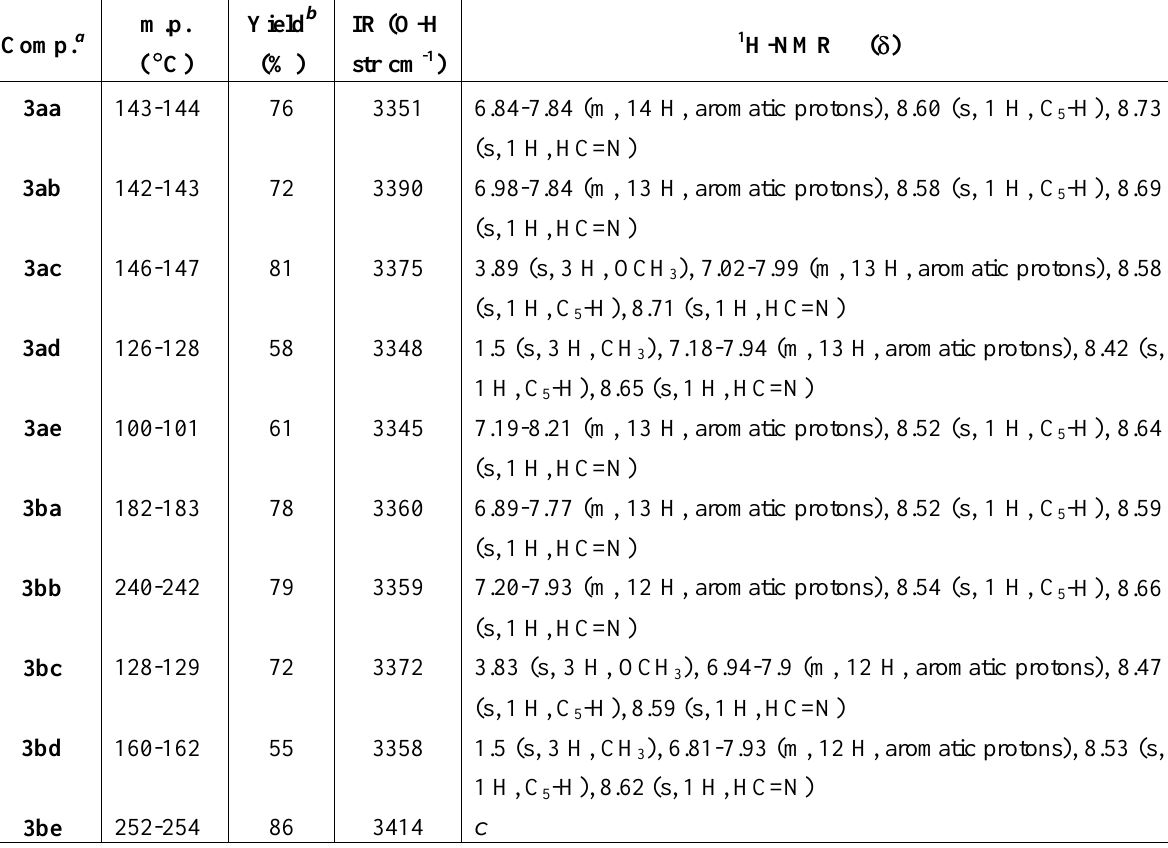
Table 2. Physical and spectral data of Schiff’s bases 3aa -